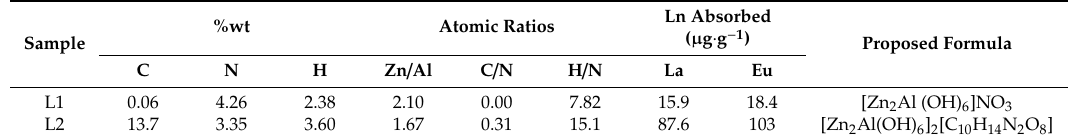
Table 4. Chemical analysis results of L1 and L2.